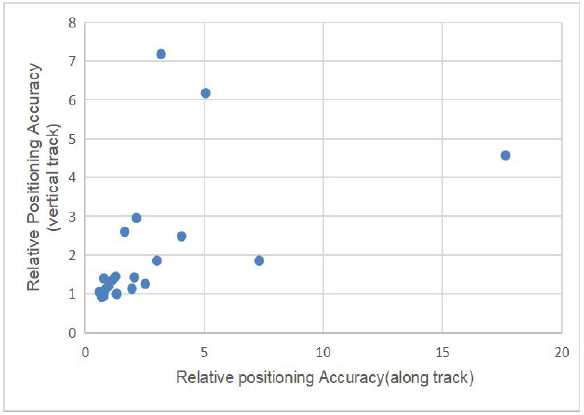
Figure 5. Spatial distribution of relative positioning accuracy absolute positioning accuracy evaluation result is better than 4 meters, there will be a shift of 6-8 pixels in the vertical or along